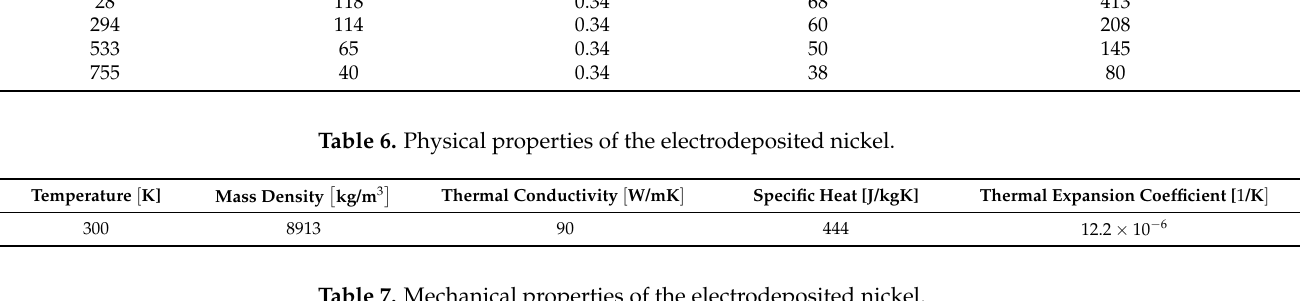
Table 7. Mechanical properties of the electrodeposited nickel.